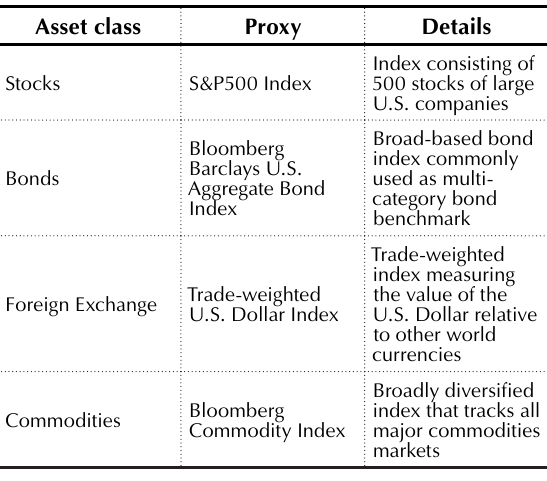
Table 2. Asset classes and their